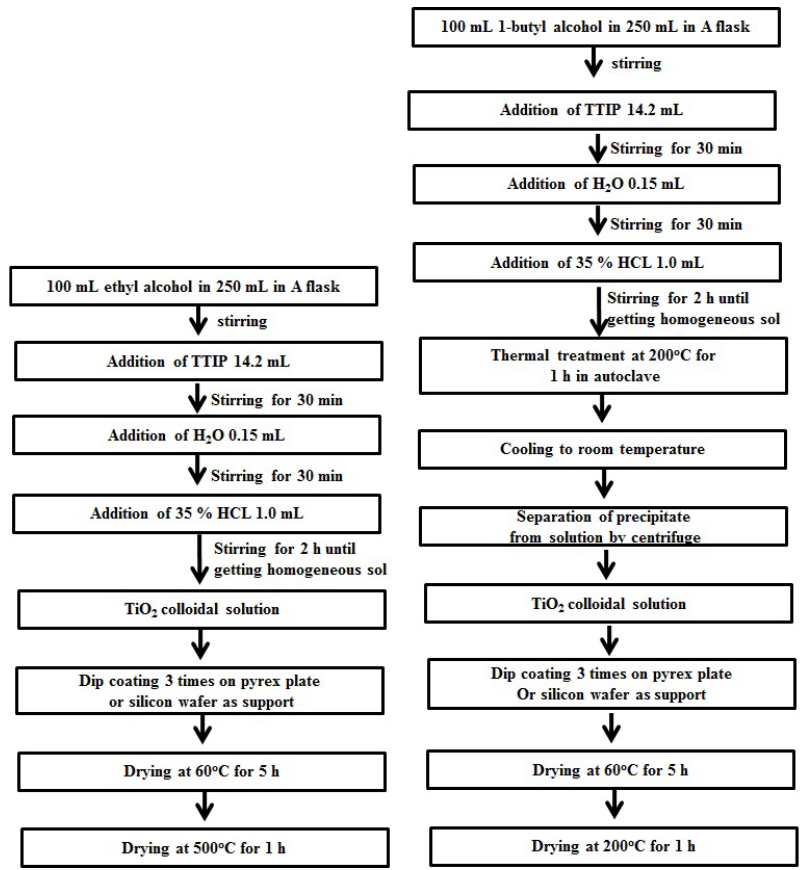
Figure 4. Preparation of TiO photocatalyst thin films by (a) sol–gel method and (b) solvothermal method [ 2